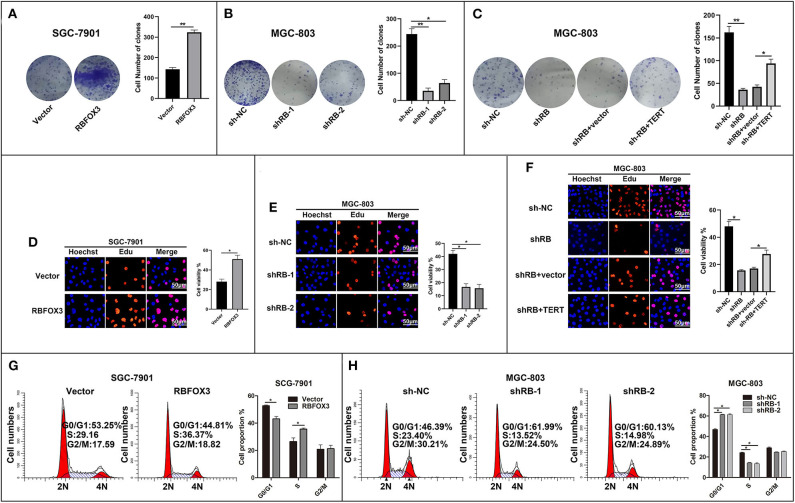
RBFOX3 promoted gastric cancer (GC) cell multiplication and cell cycle progression in vitro. (A,D) RBFOX3 overexpression increased the propagative viability of cells as well as the formation of colonies in SGC-7901 cells. (B,E) RBFOX3 silencing decreased the viability of cells as well as the capacity of formation of colonies in MGC-803 cells. (C,F) Overexpression of HTERT reverted the repression of viability of cells and colony formation moderated by the silencing of RBFOX3 in MGC-803 cells. (G,H) Flow cytometric analyses of the cell cycle of the indicated GC cells transfected with Vector/RBFOX3 and sh-NC/shRB-1/shRB-2. *p < 0.05, **p < 0.01.